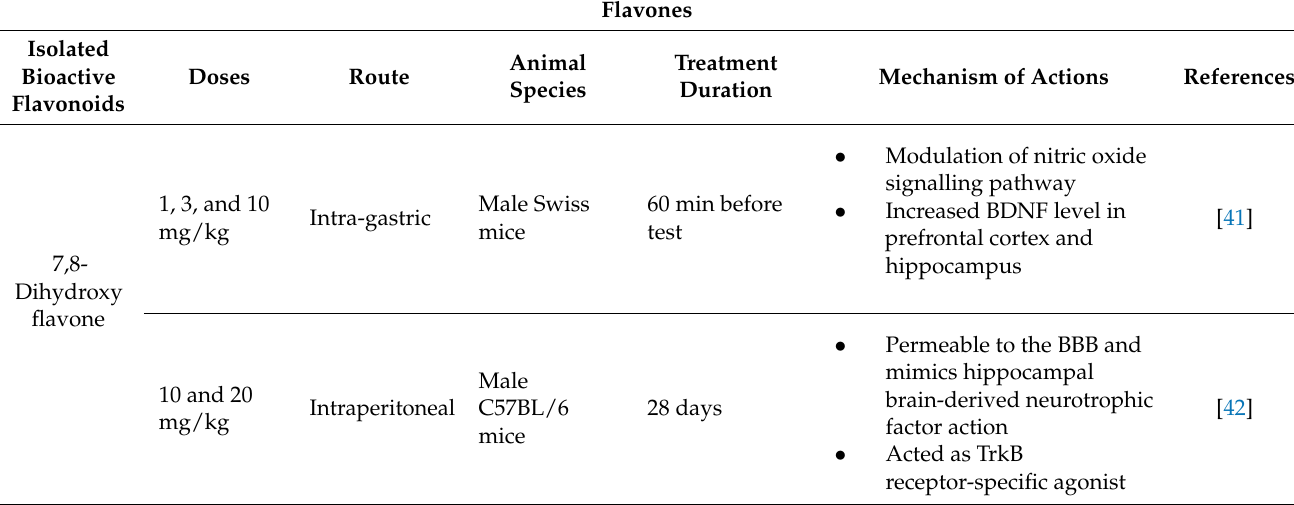
Table 5. Isolated flavonoids with anti-depressant